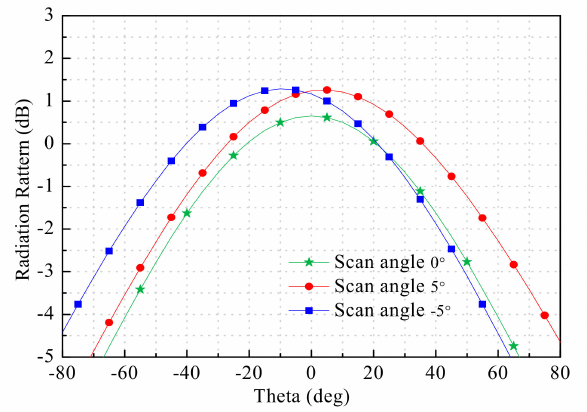
Figure 5. The beam-steering capabilities of the antenna θ (cid:15) {0 ◦ , ± 5 ◦ , ± 10 ◦ }; ϕ (cid:15) {0 ◦ , 30 ◦ , 60 ◦ , 90 ◦ , 120 ◦ , 150 ◦ }.